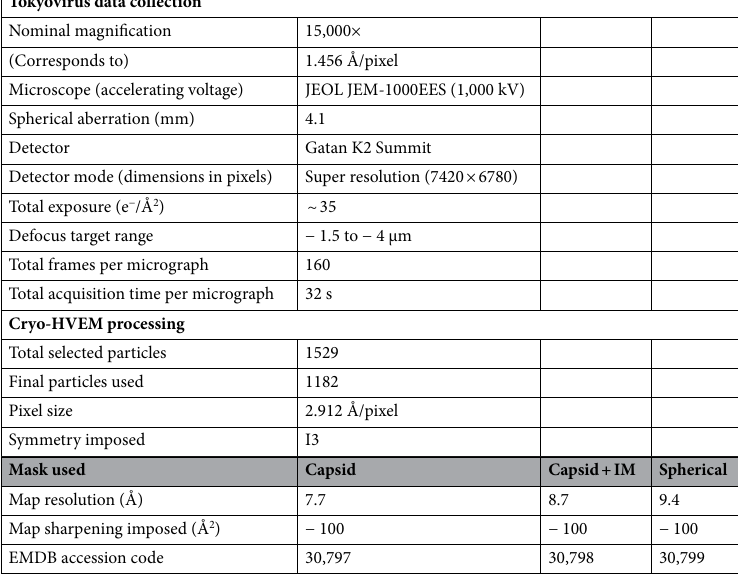
Table 1. Cryo-EM data